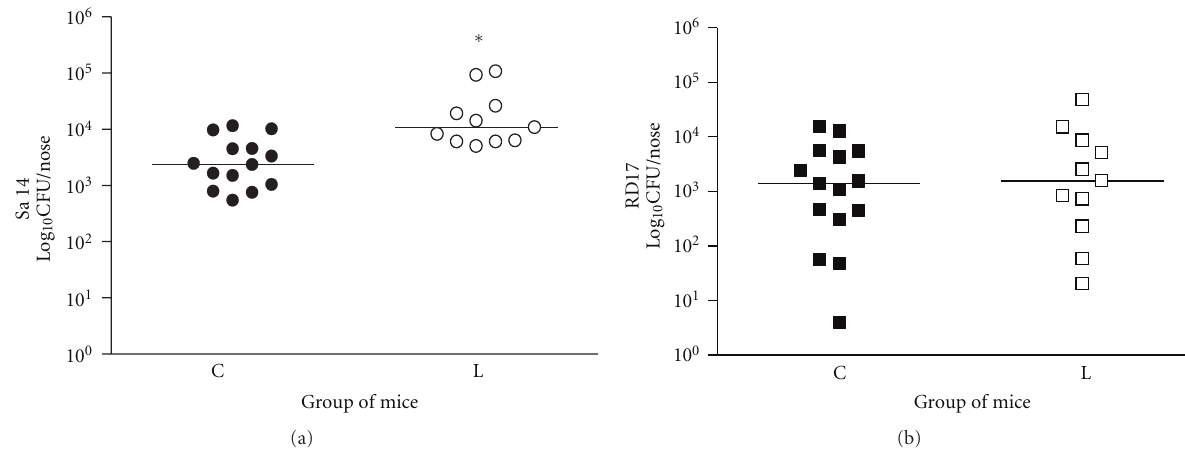
Figure 1: Nasal colonization in a mice leukopenic model. Groups of 10–15 leukopenic and control mice were inoculated intranasally with a suspension of 10 7 CFU of the Sa14 (panel a) isolate or RD17 (panel b) attenuated mutant. Challenged mice were sacrificed and their nose tissue cultured to determine CFU. The horizontal lines represent the median values. Panel (a) the leukopenic (L) mice showed a significant increase in the CFU number of the Sa14 isolate (median = 10800 CFU/nose) compared with that of control group (C) (median = 2384 CFU/ nose). ∗ P < 0 . 001, Mann-Whitney test. Panel (b): animals inoculated with the RD17 mutant showed similar CFU number in the L group (median = 1552 CFU/nose) as well as in the C group of mice (median = 1400 CFU/nose). P > 0 . 05, Mann-Whitney